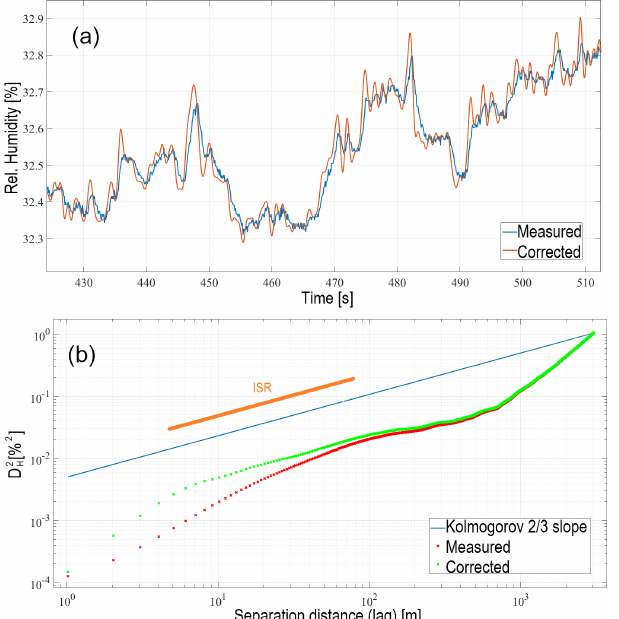
Figure 12. (a) Comparison of the measured against corrected rela- tive humidity signal. (b) Structure function comparison.